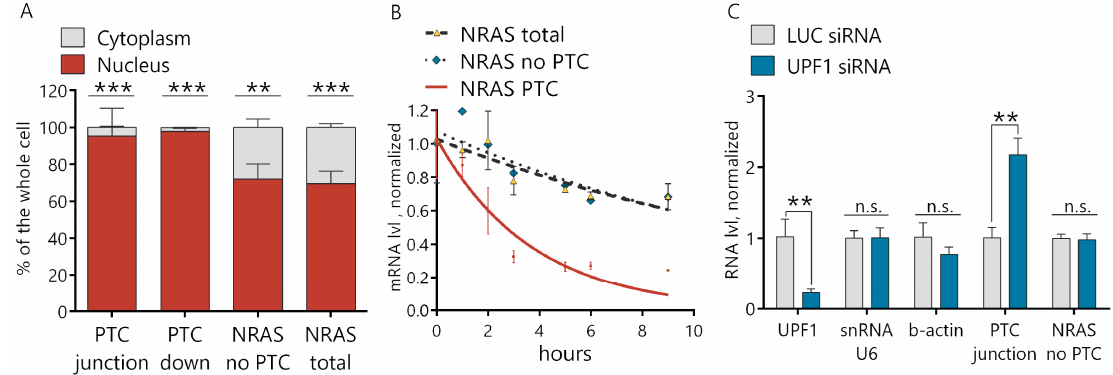
Figure 4. NRAS PTC transcript is degraded in the cytosol via the NMD pathway. ( A ) RT ‐ qPCR analysis of NRAS PTC, no PTC transcripts and NRAS total in the nuclear and cytoplasmic fractions extracted from AML12 cells. ( B ) Estimation of the NRAS transcripts degradation rate by an actinomycin D assay. ( C ) RT ‐ qPCR analysis of gene expressions after 6 days of knockdown of the UPF1 protein. Results show mean ± SD. n.s.—not significant. ** p < 0.01 and *** p < 0.001. mRNA: messenger